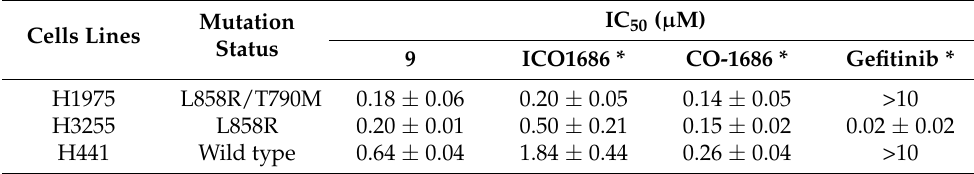
Table 1. The IC 50 of 9 , ICO1686, CO-1686, and gefitinib on NSCLC cell lines by WST-8 assay. Cells